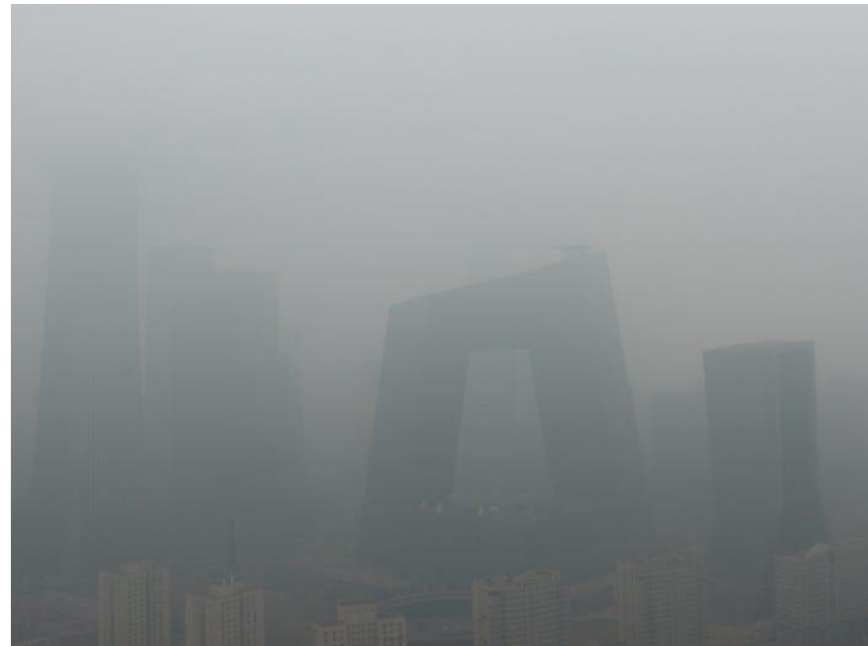
Fig. 9: Buildings are seen amid smog on a polluted day where a blue alert is issued, in Beijing - China April 2, 2018 (Reuters, 2018).